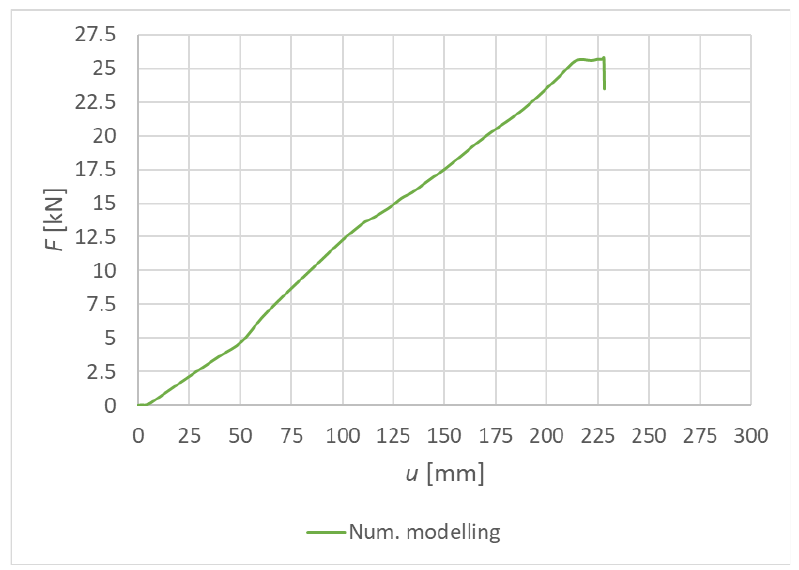
Figure 25. Experiment B: Load – deformation curves of quasi-static numerical modeling for individual specimens made from fully threaded screws.